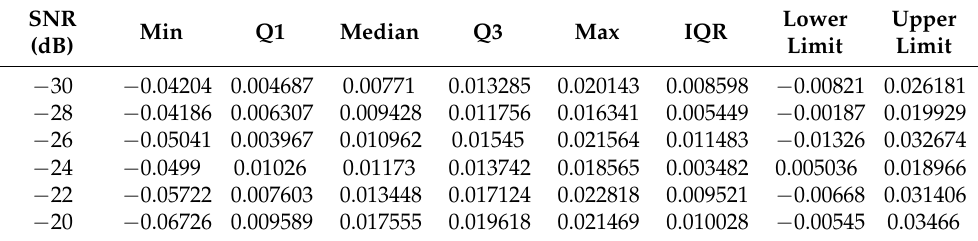
Figure 4. Correlation vs. SNR, when a random opposite malicious user (ROMU) exists in the network. Table 3. Box-whisker plot data of the correlation results under ROMU users only.